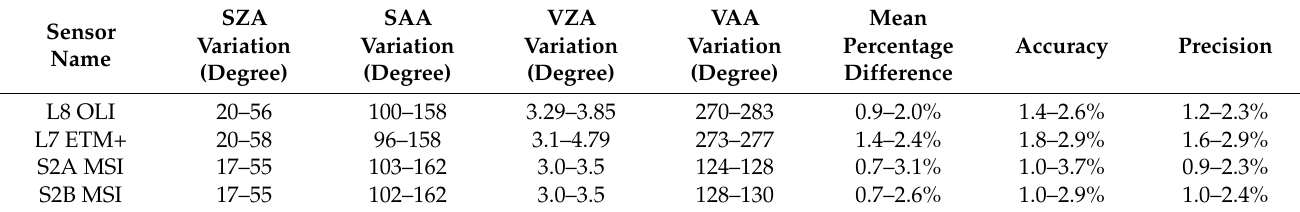
Table 12. Model specifications by analyzing different nadir viewing sensors using ROI at the edge of the scene. Sensor